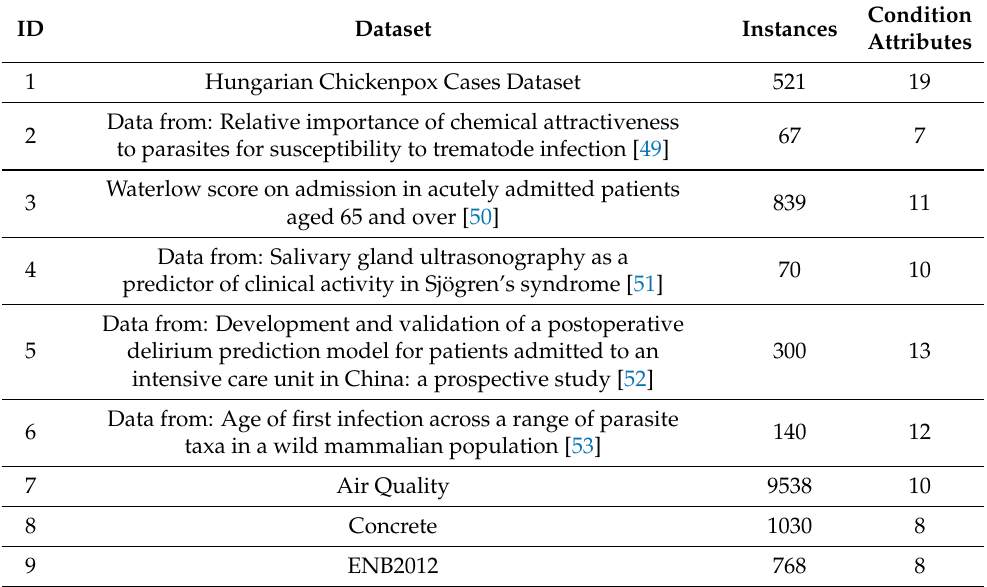
Table 1. Experimental